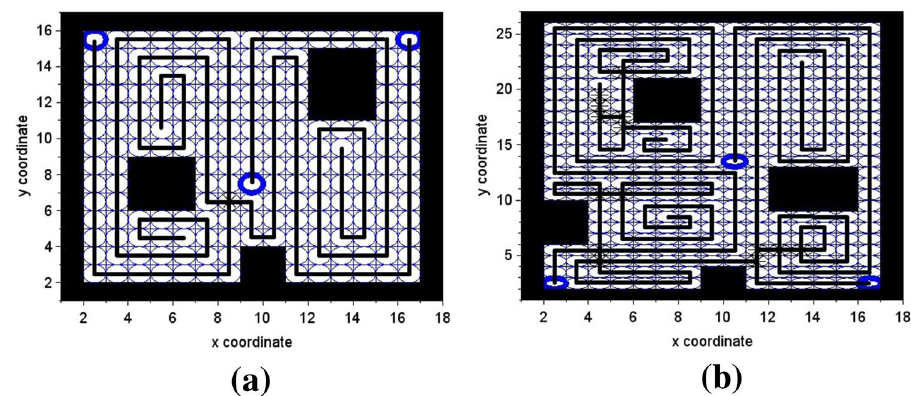
Fig. 11 Three mobile robots with different initial positions and different environmental conditions